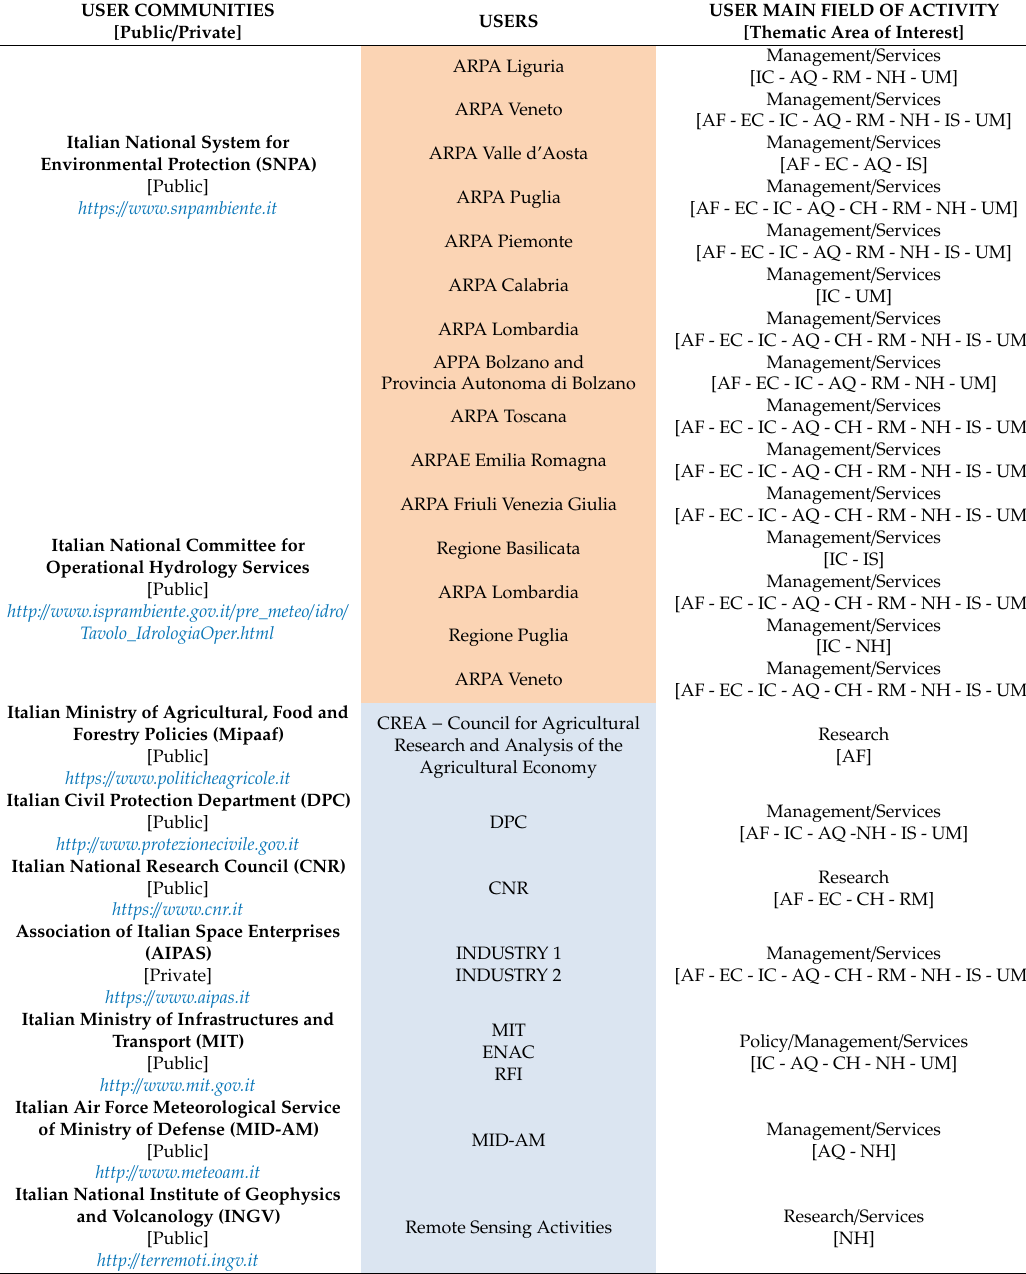
Table 4. List of public and private user communities involved in the study, with indication of the territorial reference level (national, in light blue vs. regional, in orange), the main field of activity, and the thematic areas of